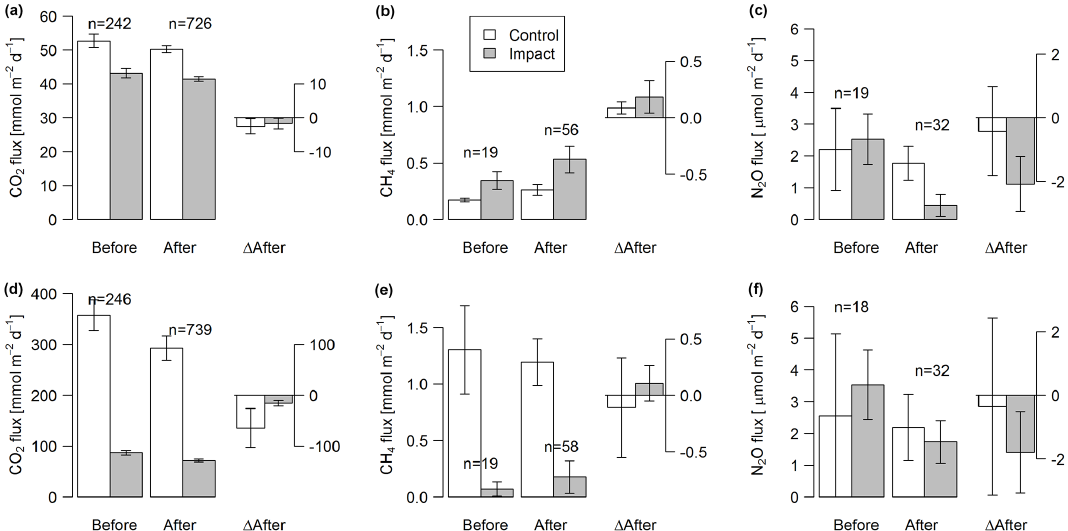
Figure 6. Fluxes of CO 2 , CH 4 , and N 2 O across the interface between lakes (a–c) or streams (d–f) and the atmosphere in control and impact catchments before and after forest clear-cutting, and the respective differences between before and after ( (cid:49) After, shown in the same units). Each bar represents mean values ( ± propagated standard errors) of repeated observations over time, summarized as arithmetic means over ten bootstrap runs that take uncertainty from gap-filling and gas flux models into account (see Fig. S3 and Text S6). Data are based on daily means of 2-hourly measurements (CO 2 ) or biweekly (CH 4 and N 2 O) concentration measurements. Lake–atmosphere fluxes are here calculated using the k model by Cole and Caraco (1998). Abbreviations: n is the number of observations.